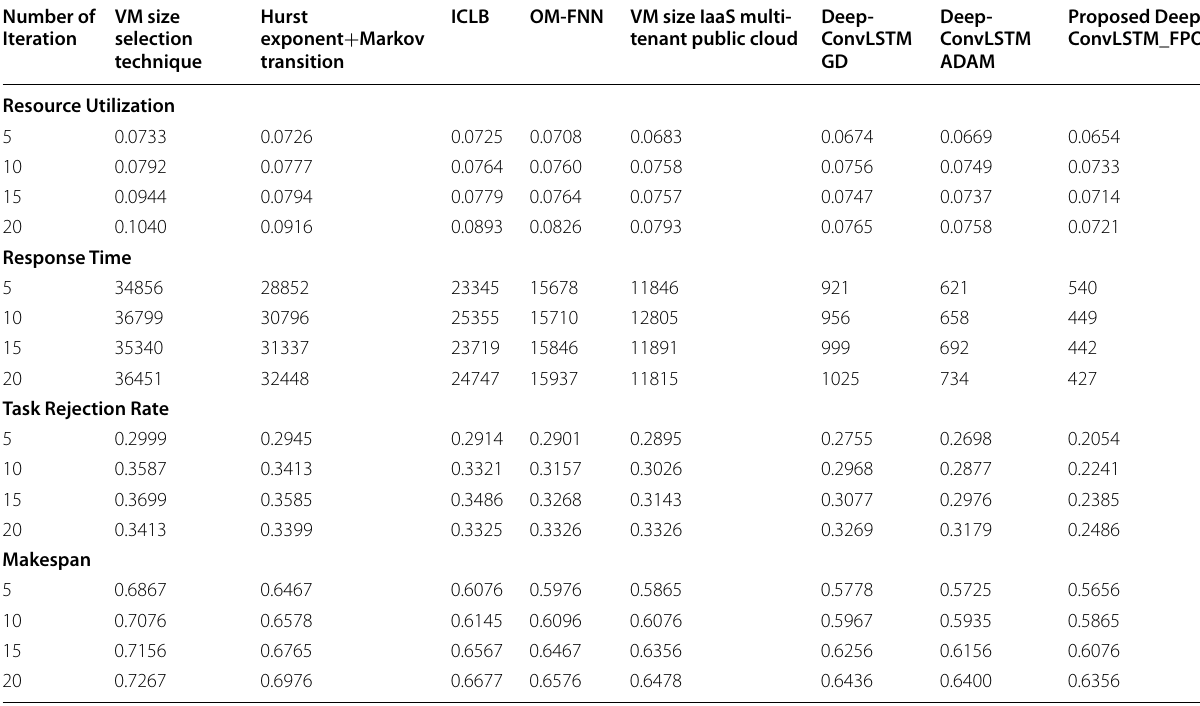
Table 7 Comparative Assessment of Deep-ConvLSTM_FPO Scheme With Task Size 200 Number of